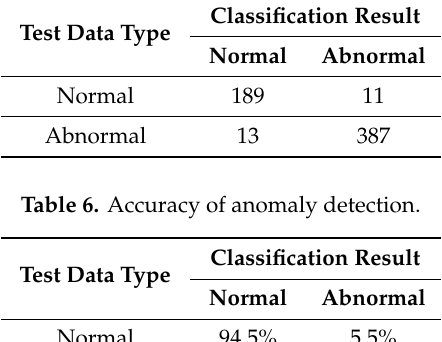
Figure 8. Results of anomaly detection: ( a ) three-dimensional vectors of test data and the normal surface; ( b ) distance from the test data to the normal surface.